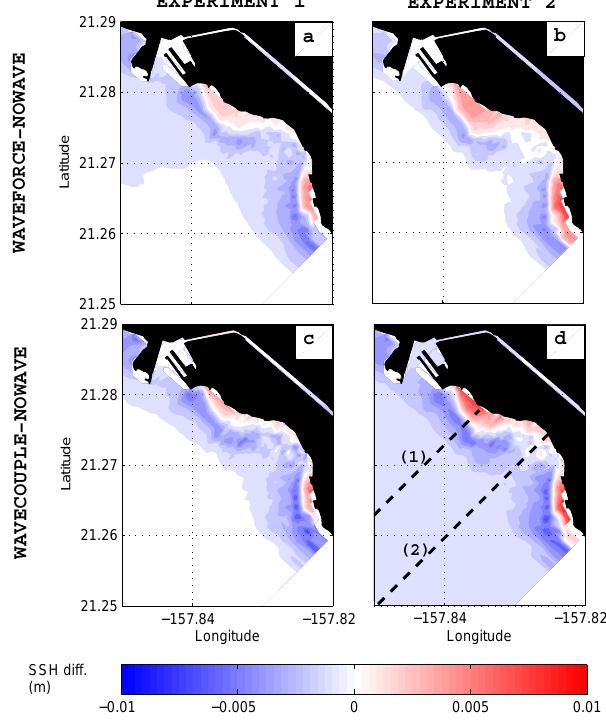
Figure 9. Time-averaged SSH difference (m) between the simula- tions that include the effect of surface gravity waves (WAVEFORCE and WAVECOUPLE) and the NOWAVE case for experiment 1 (a, c) and experiment 2 (b, d) . The black dashed lines in (d) indicate the position of the two cross-shore sections used to analyze the wave setup and the cross-shore